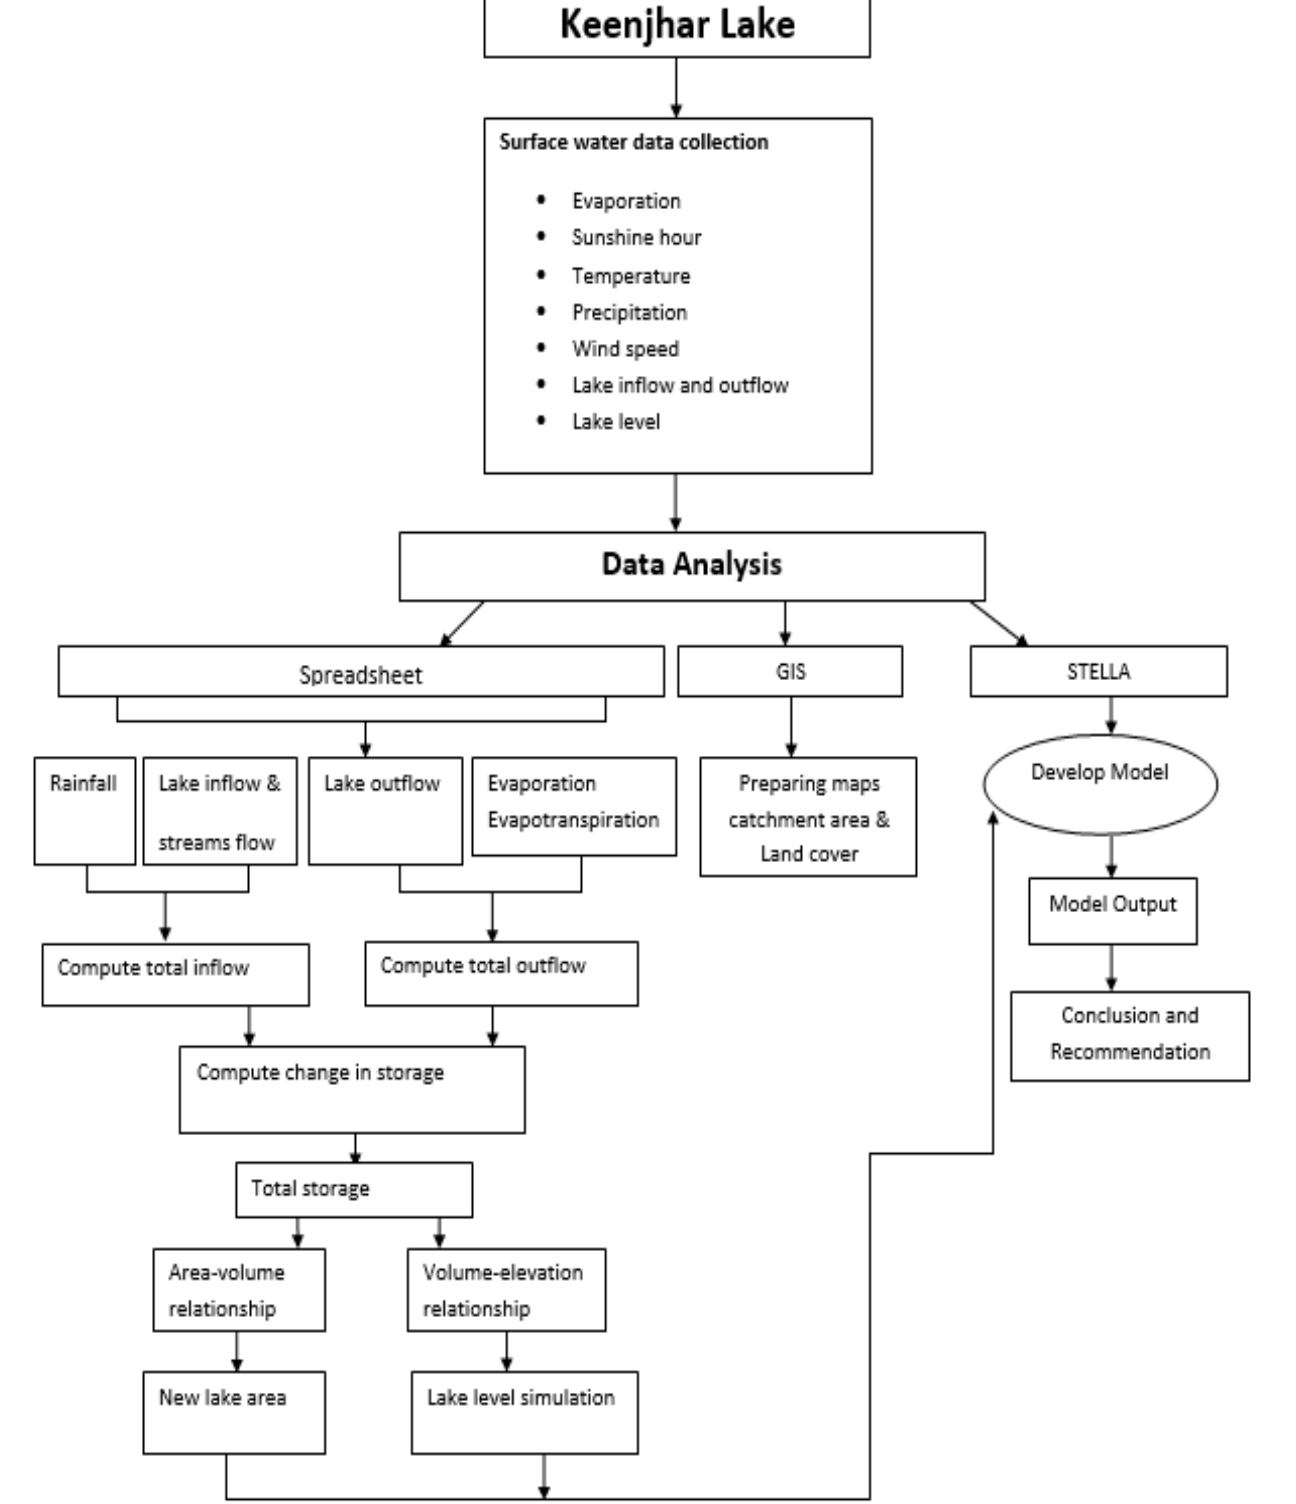
Figure 2. Methodological framework adopted in current study.